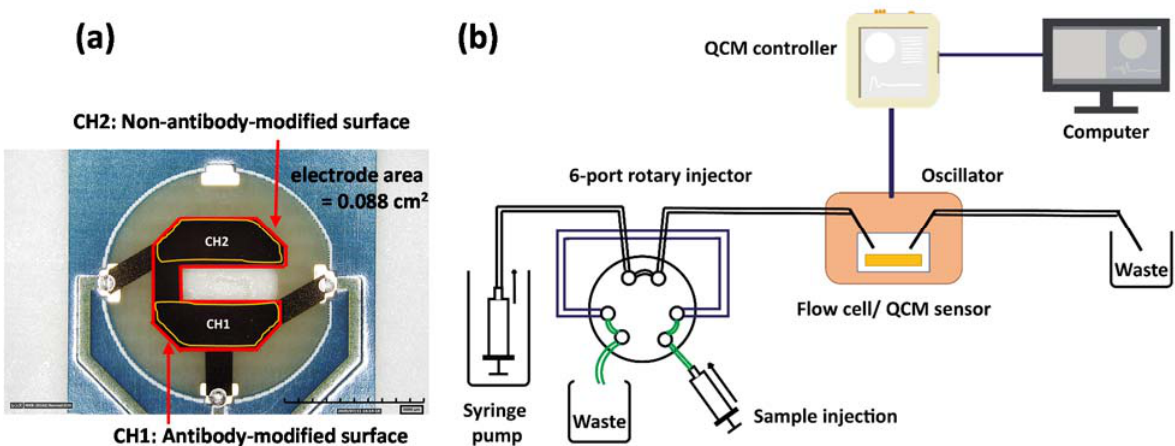
Figure 1. Measurement system: ( a ) QCM sensor chip surfaces; ( b ) schematic of the QCM sensing system for quantitative assessment of periodontal bacteria.